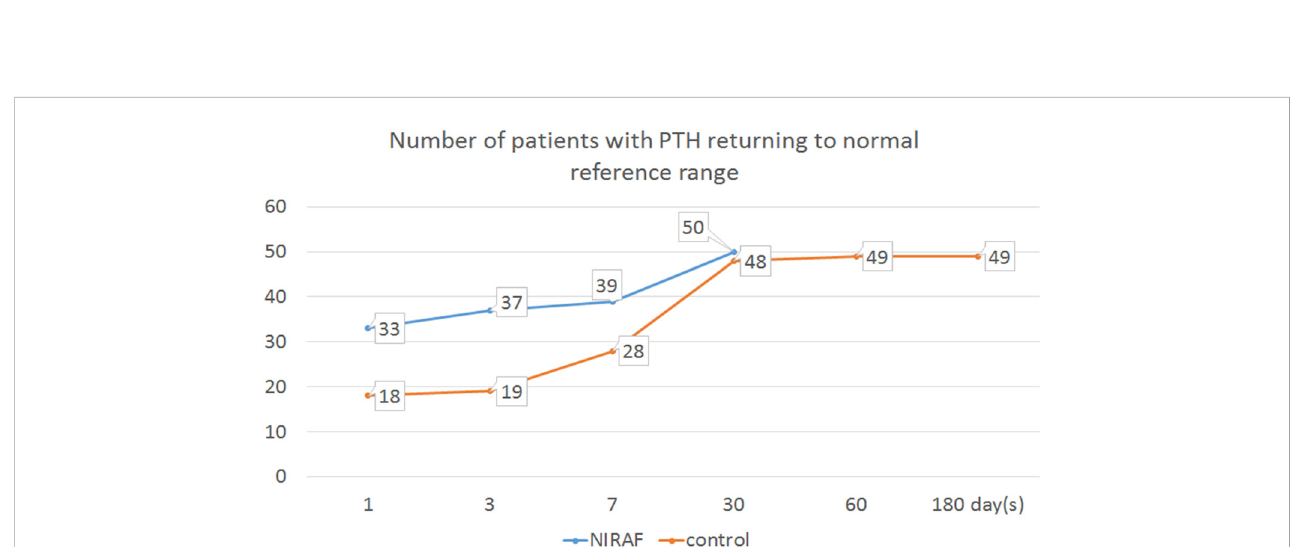
FIGURE 8 Time for PTH recovery to the normal reference range in the two groups after surgery.